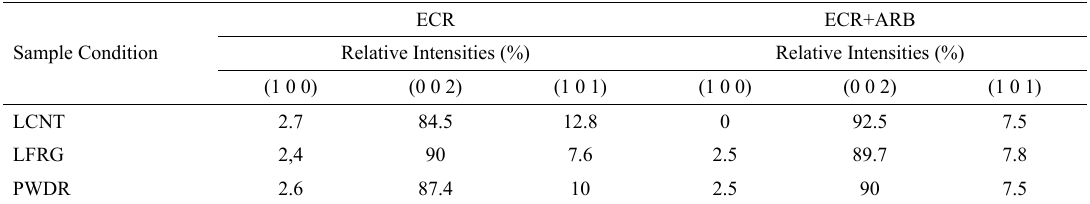
Table 1. Summary of normalized relative intensities for the three main peaks of α-Mg observed in